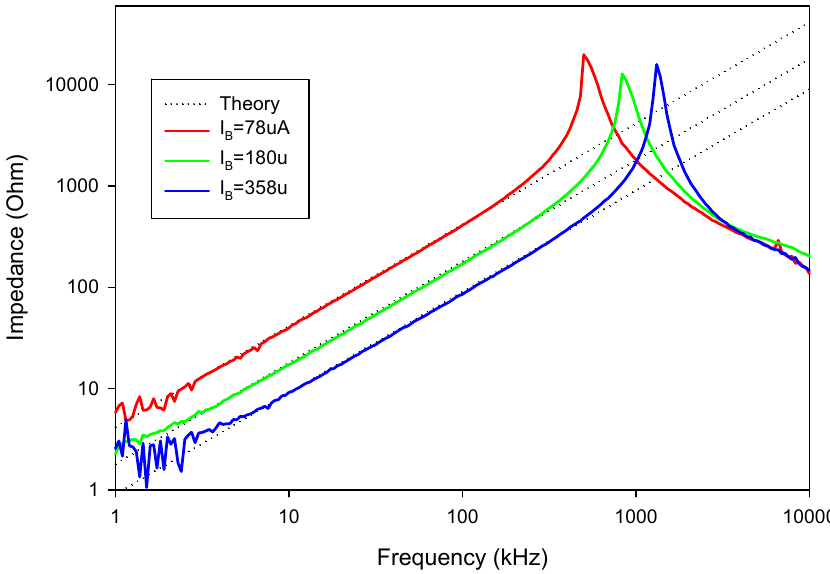
Figure 35. The experimental frequency responses of lossless L with different I B